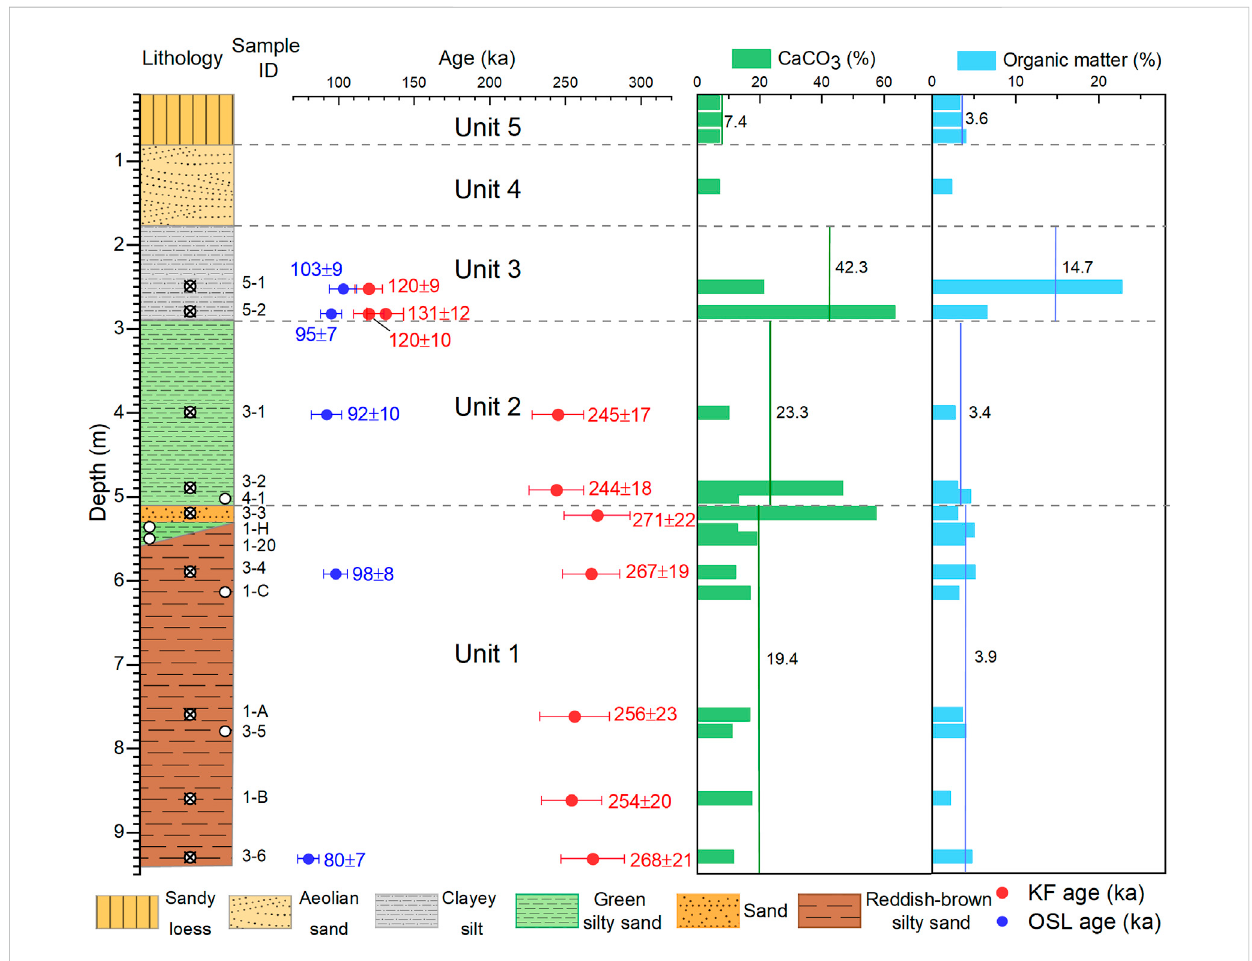
FIGURE 4 Lithological characteristics, quartz OSL, and KF MET-pIRIR ages and contents of carbonates and organic matter in HLG section.